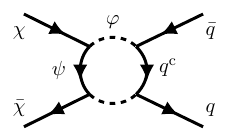
Figure 9 . Unique diagram for loop-induced dark matter annihilation to quarks, χ ¯ χ → q ¯ q . Note the color-conjugated quark q c in the